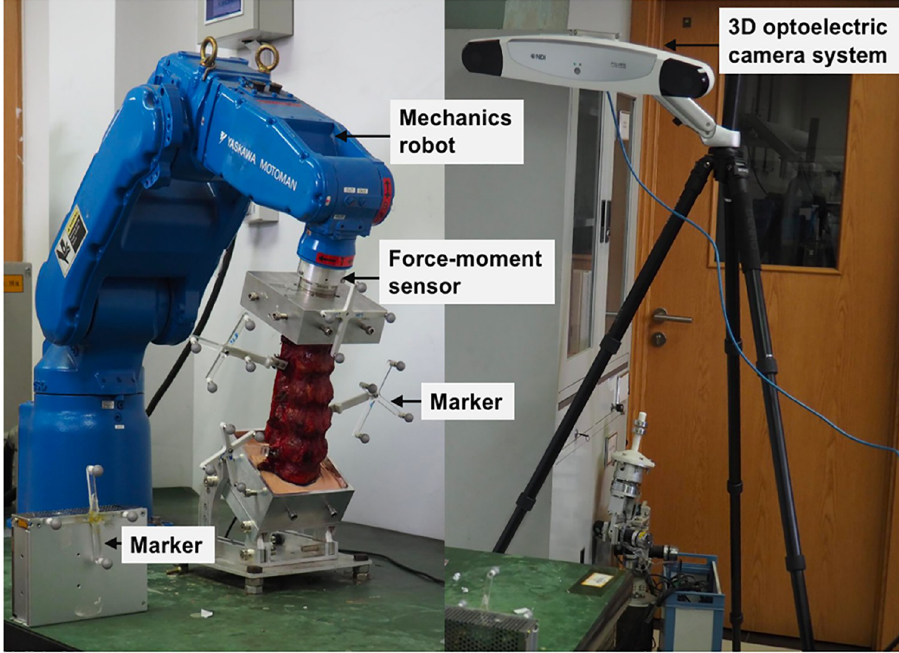
Fig 2. Image of the robotic testing device with a specimen embedded.